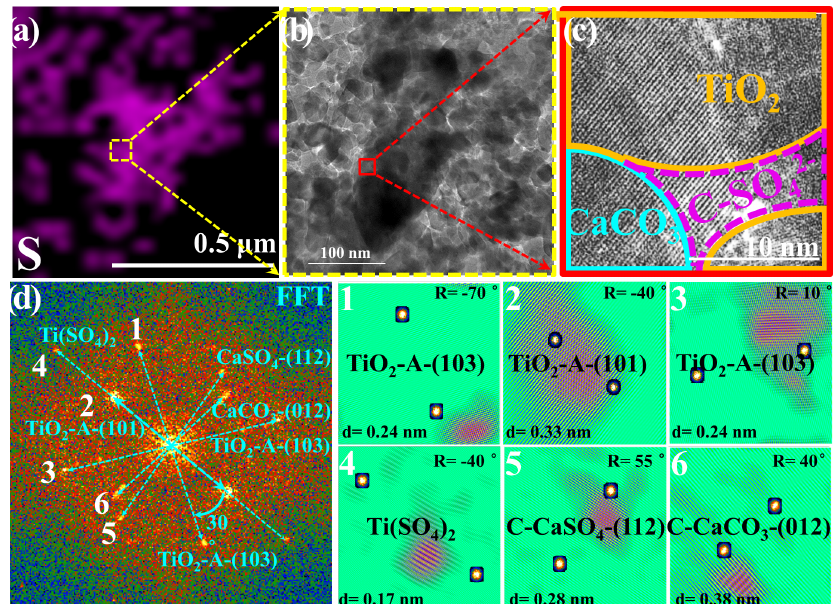
Figure 3. (a) Energy dispersive spectroscopy (EDS) mapping of sulfur. (b) A selected HRTEM (high-resolution transmission electron microscopy) region containing a high density of sulfur for further observation is shown, and the red rectangle refers to the region shown in panel (c) . (c) The HRTEM image in high resolution with lattice fringes and (d) corresponding fast Fourier transform (FFT) power spectra, lattice indexing, and (1–6) the inverse FFT analysis of lattice signal is shown in panel (d) . In panel (c) , the term C-SO 2 − SO 2 − , i.e., CaSO 4 and Ti(SO 4 ) 2 . Particles employed for the HRTEM measurement refer to TiO 2 (50wt%) + CaCO 3 (50wt%) mixture 4 particles upon exposure to the 4.42 × 10 14 molec.cm − 3 SO 2 / N 2 + O 2 for 60min, while other reaction conditions are as same as those of the above sulfate quantification experiments in Fig. 1. Reaction conditions are RH of 30%, light intensity ( I ) of 30mWcm − 2 , and total flow rate of 52.5mLmin − 1 .